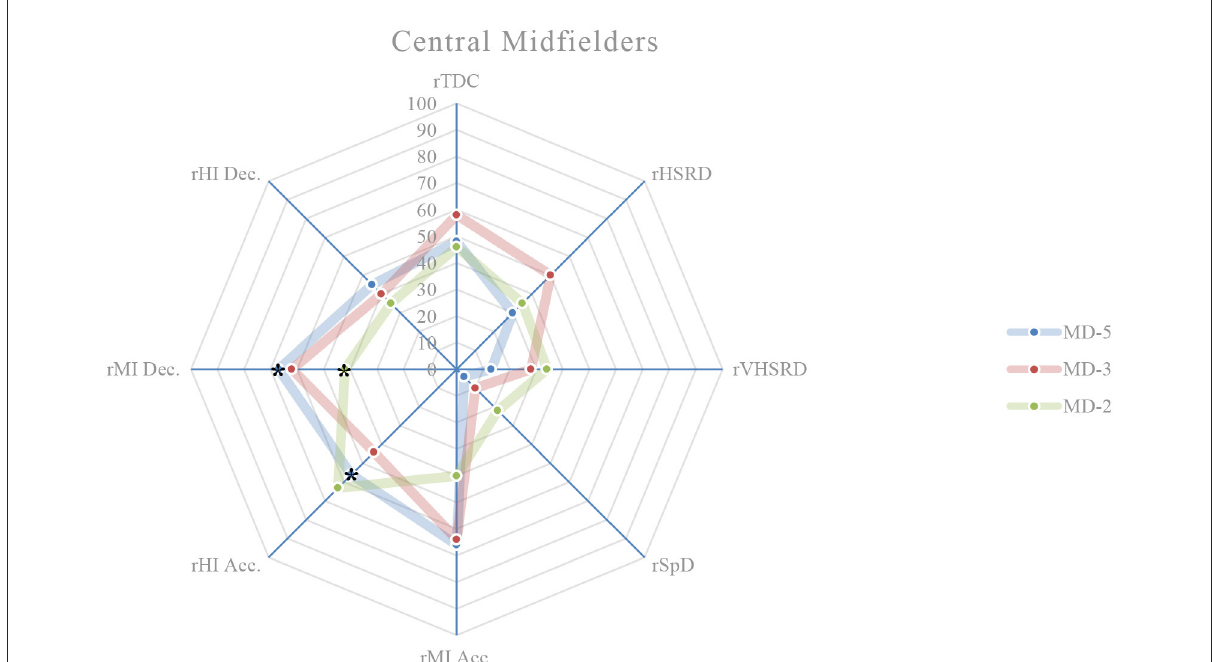
FIGURE3 Daily external load (based on MRef) of central midfielders. *Location of the significant differences, p < 0.05.